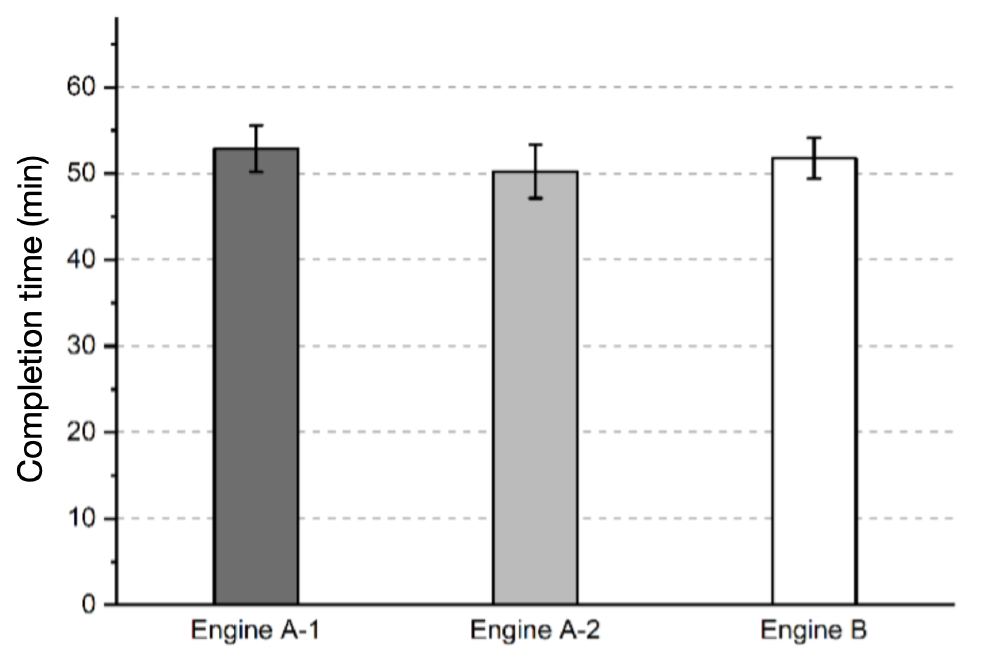
Figure 34. The mean of completion time of engine maintenance